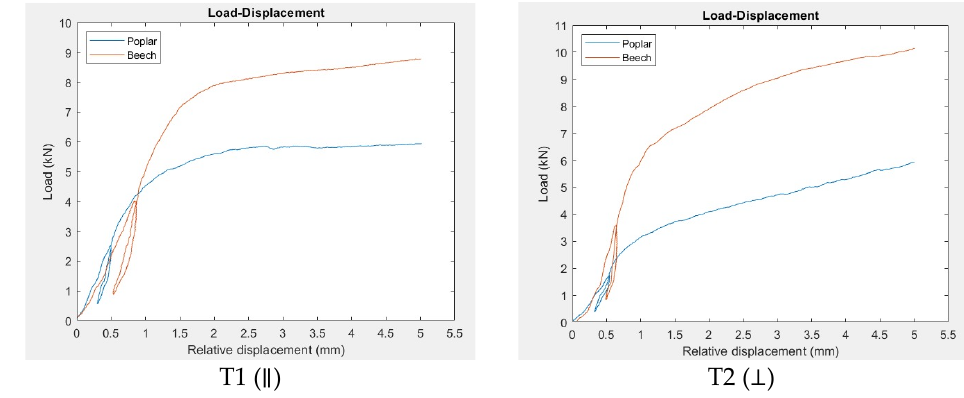
Figure 6. Comparison of load–displacement diagram between species for tests with screws.